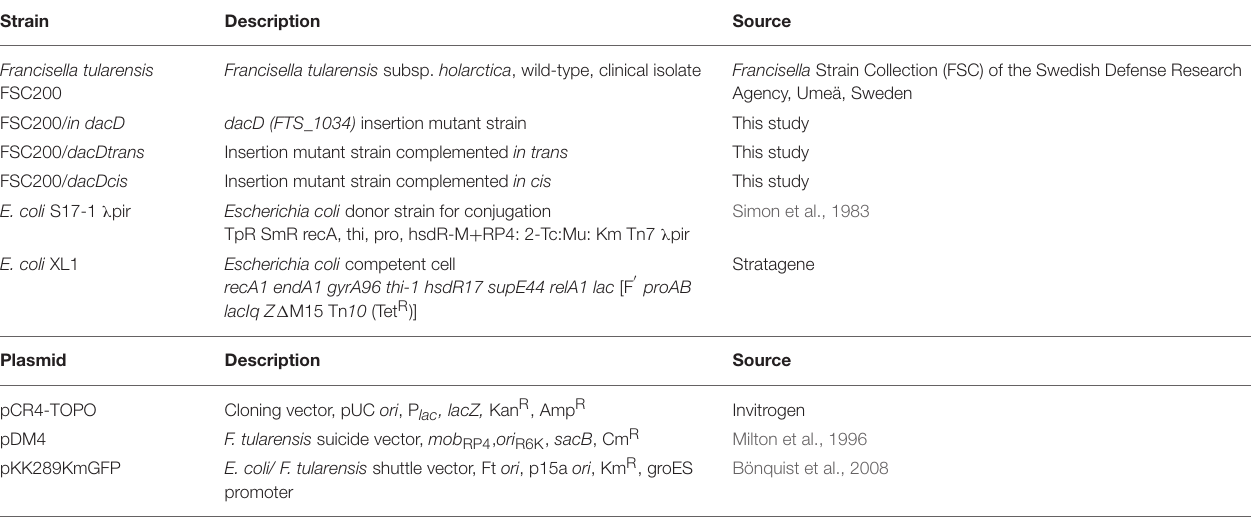
TABLE 1 | Bacterial strains and plasmids used in this study.